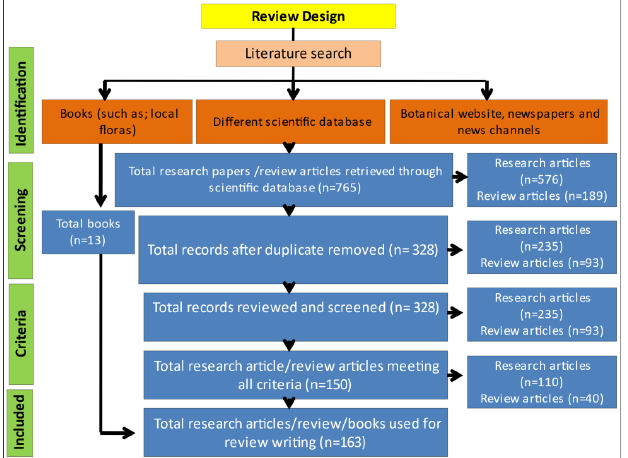
Figure 3. Flowchart for study design.